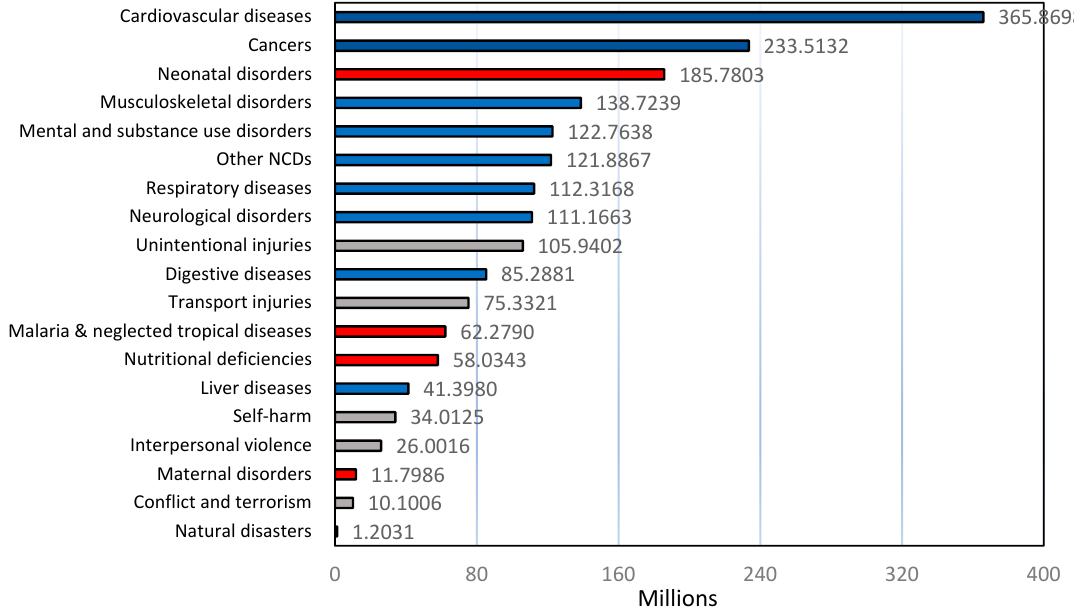
Figure 19. Total disease burden in the world in 2017, measured using the value disability-adjusted life years (DALYs) on millions. One DALY equals to one lost year of healthy life. Information provided by M. Roser and H. Ritchie, “Causes of Death”. Published online at OurWorldInData